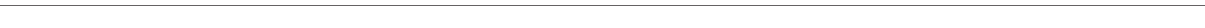
FigUre 5 | Interferon (IFN)- λ 2/3 exerts a potent antiviral effect against influenza A virus (IAV) infection in the mouse lung. Non-asthmatic mice ( N = 5) and asthmatic mice ( N = 5) were infected with 213 pfu IAV WS/33 (H1N1), and body weight (a) and survival rate [ (B) , N = 20] were assessed until 14 dpi. The mRNA levels of TNF- α , IL-1 β , and Ccl7 (c) and the levels of secreted IFN- λ 2/3 and IFN- γ (D) in the lung and bronchoalveolar lavage fluid were determined. Asthmatic mice were infected with 213 pfu IAV WS/33 (H1N1) and treated with recombinant IFN- λ 2/3 (IFN- λ 2 : 1 μ g and IFN- λ 3 : 1 μ g/30 μ l) ( N = 5). As a control, the diluent phosphate- buffered saline was used ( N = 5). Survival rate [ (e) , N = 20], hematoxylin/eosin-stained lung histologic findings (F) , and viral titer (g) were determined at 14 dpi. Micrographs are representative of lung sections from five mice. Polymerase chain reaction, plaque assay, and enzyme-linked immunosorbent assay results are presented as mean ± SD from five independent experiments (* p < 0.05 compared with the values of mice with recombinant IFN- λ 2/3